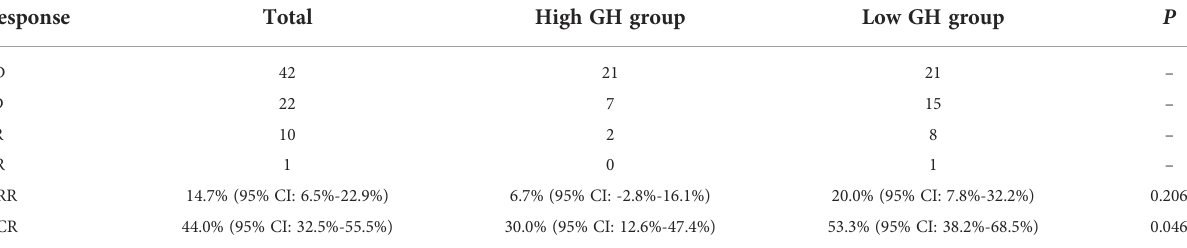
TABLE 2 Effect of posttreatment GH levels on ICI ef fi